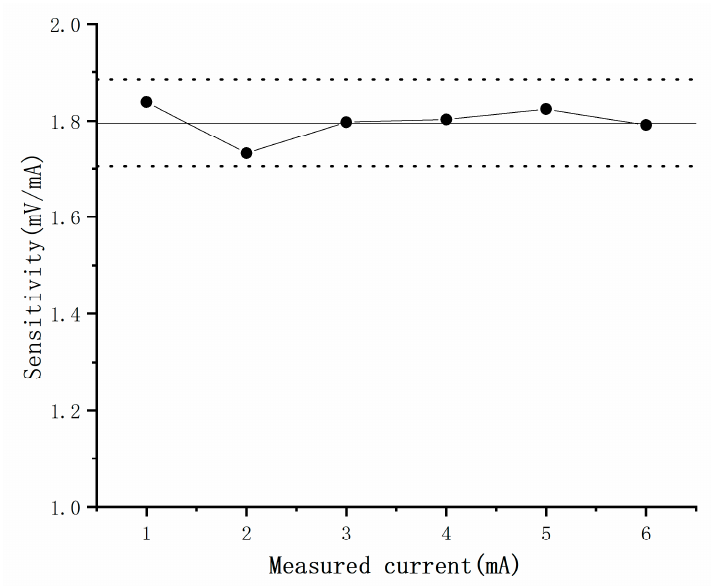
Figure 14. Variation curve of sensor Figure 14. V ariation curve of sensor sensitivity.